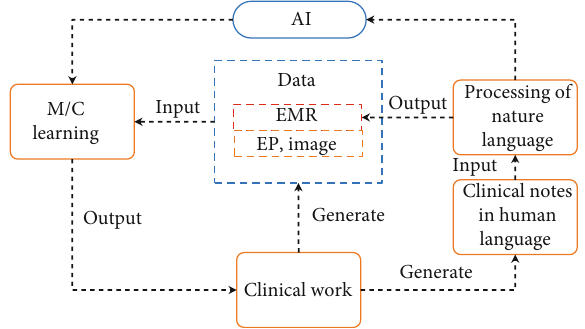
Figure 2: Plan for medical data